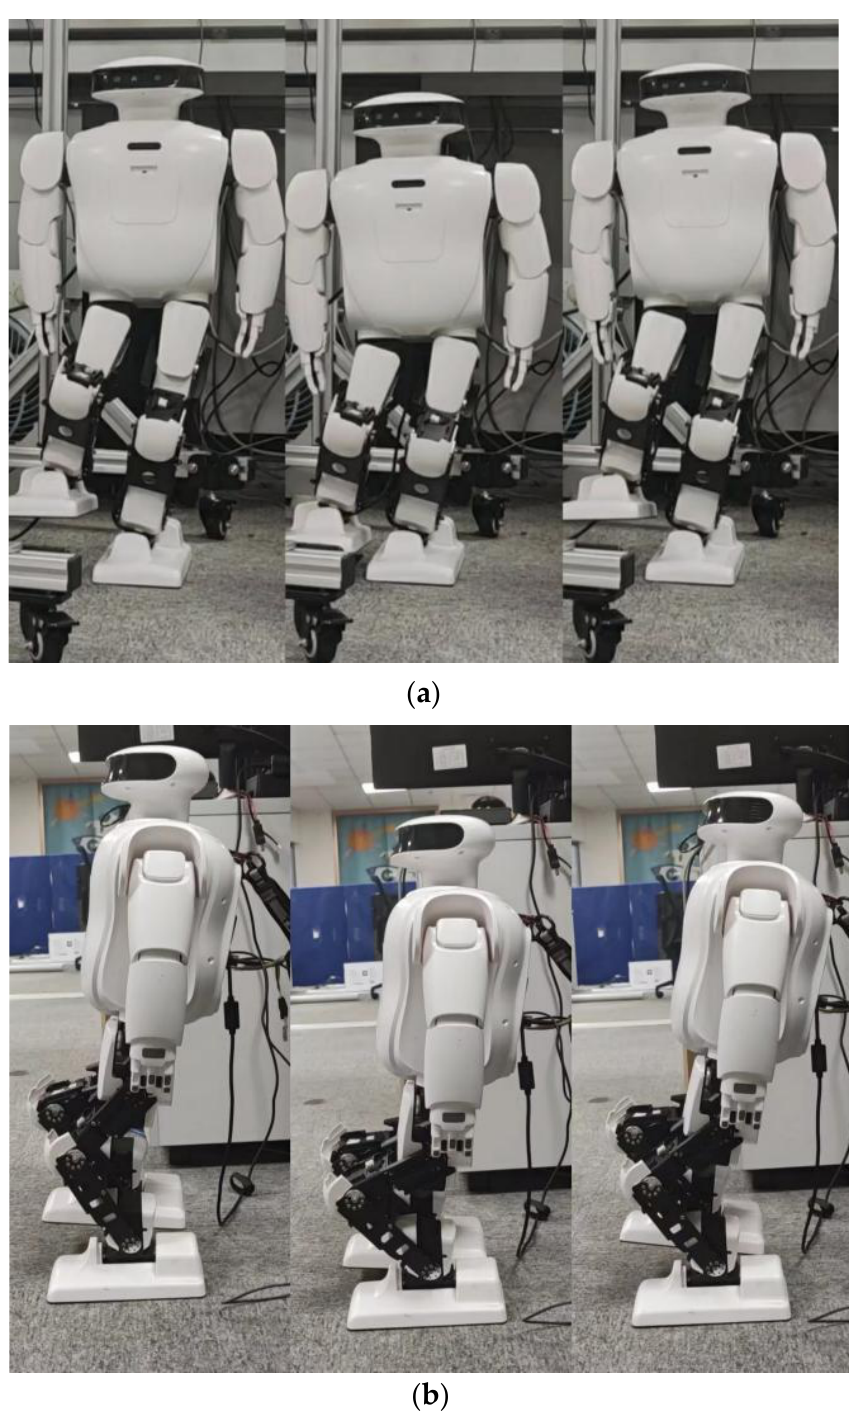
Figure 11. When Roban’s COM moves 5 cm, it completes three squats on a single leg. ( a ) A main view of the robot squatting process; ( b ) A side view of the robot squatting process. According to Figure 12, the idea that the Roban robot has large error under pure position compensation is verified. In order to compensate for the error, we adopted the spring compensation method. In the Drake platform, the joint torque feed forward of the robot is obtained through the aforementioned simulation experiment as shown in Figure